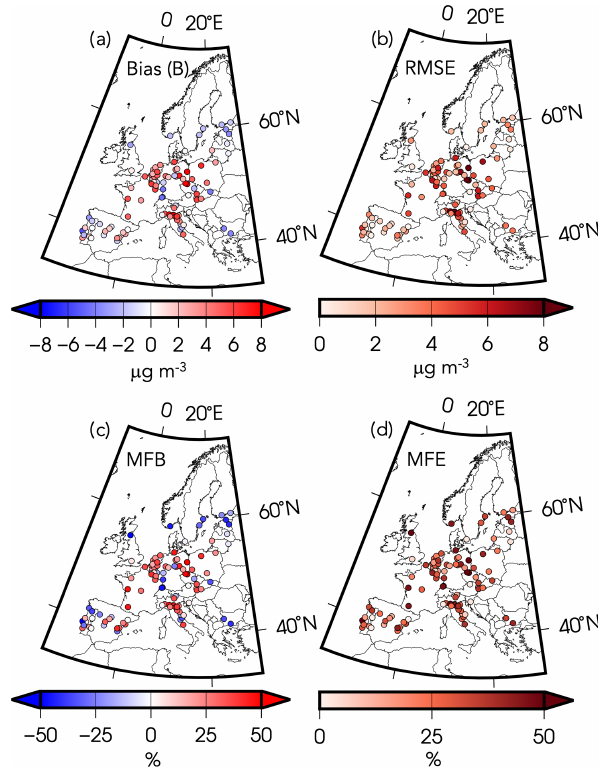
Figure 2. Results of model validation for PM 2 . 5 simulations: (a) mean bias ( B , µgm − 3 ); (b) root mean square error (RMSE, µgm − 3 ); (c) mean fractional bias (MFB, %); (d) mean fractional error (MFE,